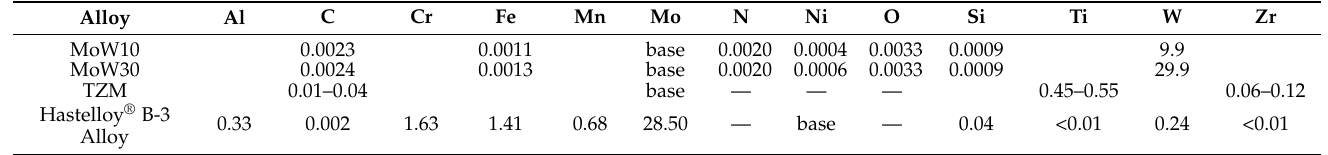
Table 2. Composition of studied alloys according to the manufacturers’ certificates, wt.